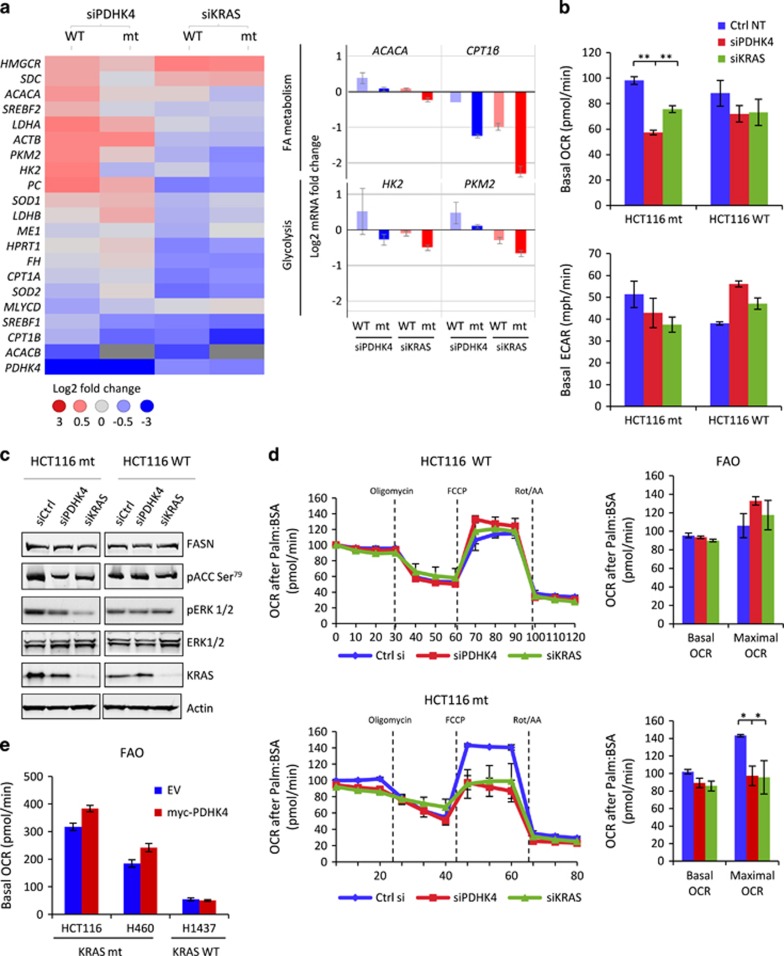
PDHK4 depletion causes opposite metabolic changes in mutant and wild-type KRas cells. (a) Fluidigm expression analysis was performed in isogenic HCT116 cells after PDHK4 and KRAS knock-down for 48 h. A heatmap of some of the most relevant genes involved in different metabolic pathways was generated normalizing to TFRC house-keeping gene and represents the log fold change Ct values n=3 as indicated (3 to −3). Bar charts on the right represent some of the metabolic genes downregulated in mutant cells after both KRAS and PDHK4 depletion compared to WT cells. (b) Seahorse Bioscience XF96 extracellular flux analyser was used for the real-time determination of metabolism in isogenic HCT116 cells after 48 h of KRAS and PDHK4 siRNA treatment (10 nM). Basal OCR (upper chart) and ECAR (lower chart) rates were quantified by SeaHorse analysis and normalized to protein content after Glucose (10 mM) and glutamine (2 mM) addition 2 h before the assay. (c) Western blot analysis in HCT116 cells as indicated show the effect on ACC and ERK phosphorylation, FASN, KRAS and Actin protein levels after 40 h of PDHK4 and KRAS siRNA treatment (10 nM). (d) Exogenous fatty acid utilization was analysed by the SeaHorse analyser XF96 in isogenic HCT116 cells after 48 h of PDHK4 and KRAS knockdown, and 45 min after addition of 30 μM of BSA-palmitate as the only substrate. Oligomycin (2.5 μg/ml), FCCP (1.5 μM), rotenone (2 μM) and antimycin A (4 μM) were added at the same time point for each experiment. Basal fatty acid oxidation corresponded to the last OCR measurement before Oligomycin addition. Quantification of the maximal FAO rate was determined by the difference of the OCR rate after FCCP addition and the OCR rate after Rotenone/antimycin (Rot/AA) addition. (e) Cell lines indicated were transfected for 24 h with the empty vector (EV) control and a full length PDHK4 construct and FAO SeaHorse analysis was performed as in (d). All graphs show the mean±s.e.m (n=3) and P-values were calculated according to t-student scores **P<0.05 two-sided paired t-test. BSA, bovine serum albumin